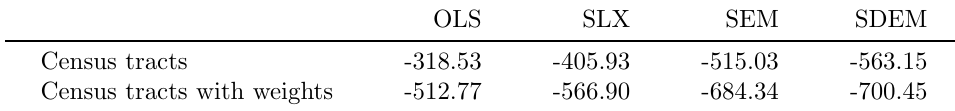
Table A.4: Model AIC values for observations on 489 non-censored census tracts